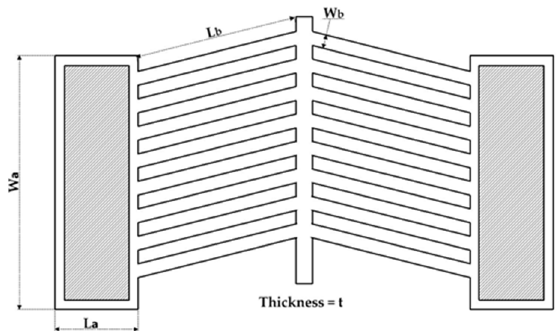
Figure 4. Schematic chevron actuator of eight pairs of beams.